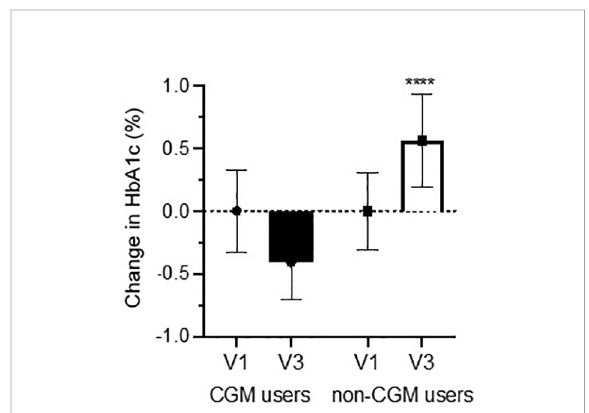
FIGURE 1 Baseline-corrected change in HbA1c pre- & post-remote visit.. Change in HbA1c for people with T1D who used continuous glucose monitoring (CGM users; n =23) or not (non-CGM users, n =17) before (V1), during (March-September 2020), and after (V3) the transition to virtual visits. Bars represent the mean change between the value obtained at V1 and V3, for their respective group. All patients were followed exclusively in our longitudinal fellows ’ clinic and by a single fellow. Data are expressed as mean ± SEM. **** P